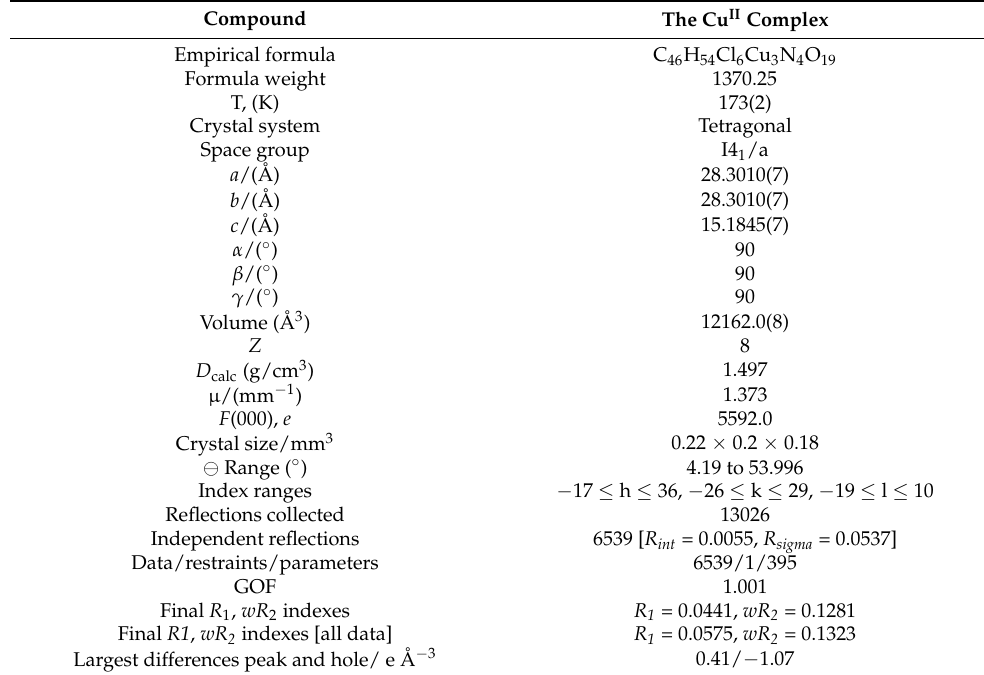
Table 1. Crystal and refinement parameters data of the Cu II